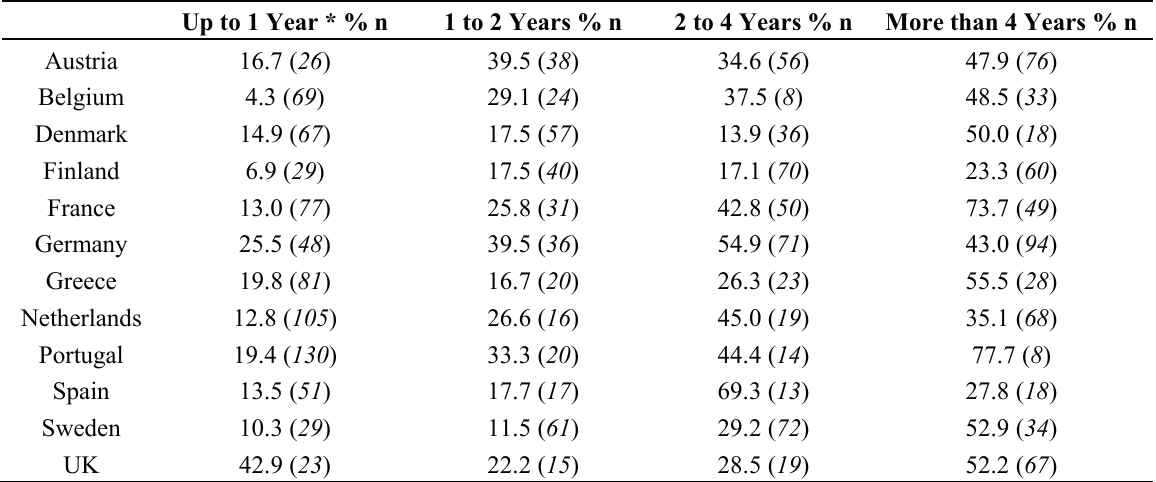
Table 4. Perceived negative career consequences among mothers with different times spent full-time at home.